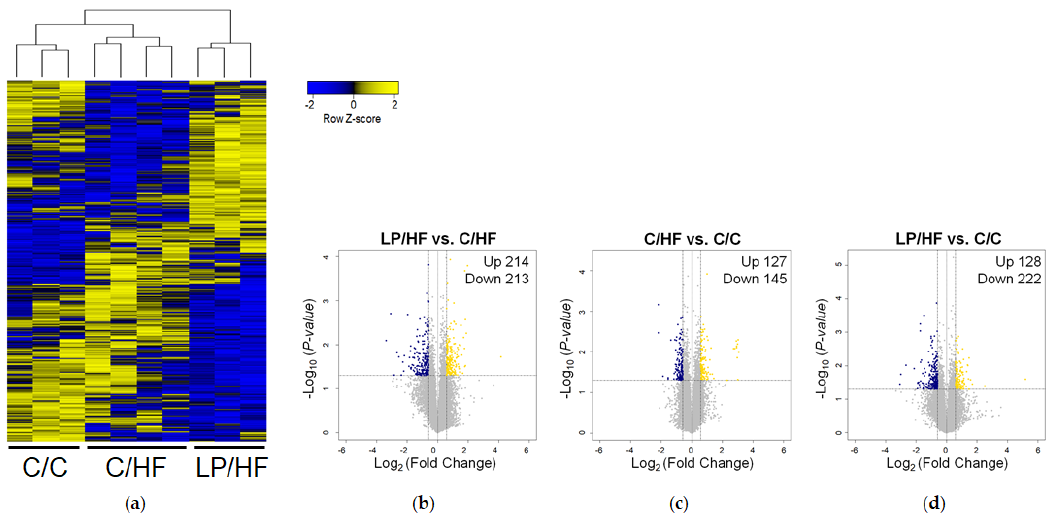
Figure 2. Global gene expression profile in o ff spring epididymal adipose tissue. ( a ) Two-dimensional hierarchical clustering of gene expression profile. Each cell represents the z-score normalized expression of di ff erentially expressed genes (DEGs) across di ff erent samples, identified by t -tests between three of each pairwise comparison ( P < 0.05, | fold change | ≥ 1.5). ( b–d ) Volcano plots ( P -value versus fold change) of DEGs from LP / HF versus C / HF comparison ( b ), C / HF versus C / C comparison ( c ), and LP / HF versus C / C comparison ( d ). Yellow dots represent the up-regulated genes, and blue dots represent the down-regulated genes by the criteria of P < 0.05, | fold change | ≥